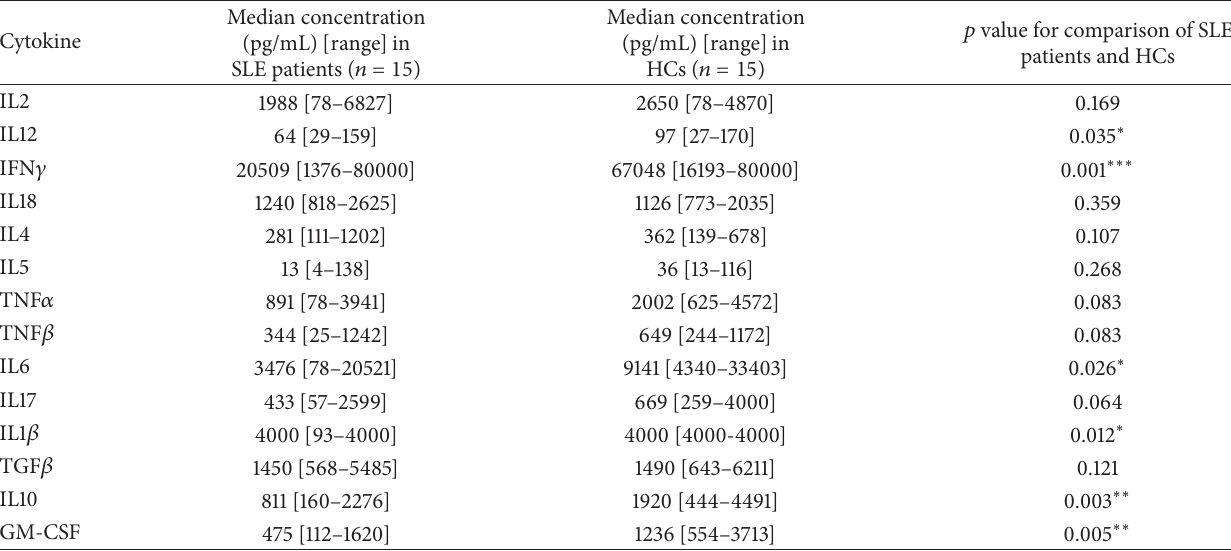
Table 3: Cytokine responses in SLE patients and HCs upon SEB